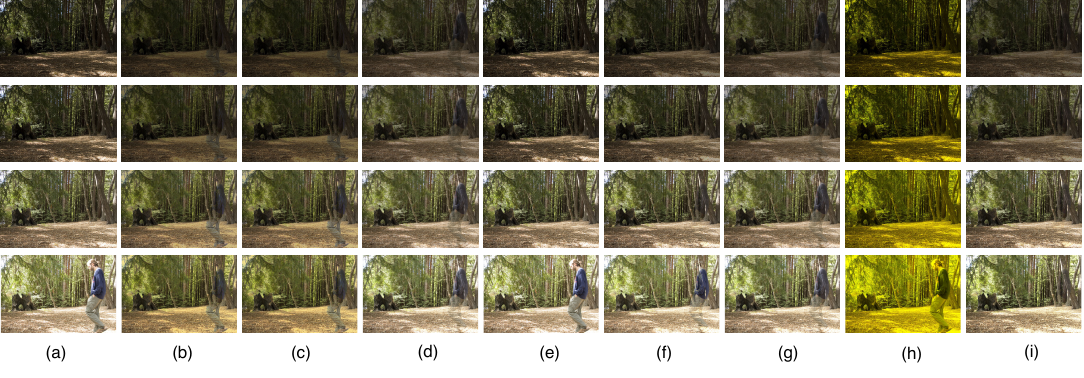
Figure 5. High dynamic range imaging. ( a ) Input images (four) and low-rank term X obtained by RPCA ( b ), LR-MDL ( c ), CoGEnT ( d ), BSGFL ( e ), PSSV ( f ), ROUTE ( g ), FGSR ( h ) and the proposed approach ( i ).